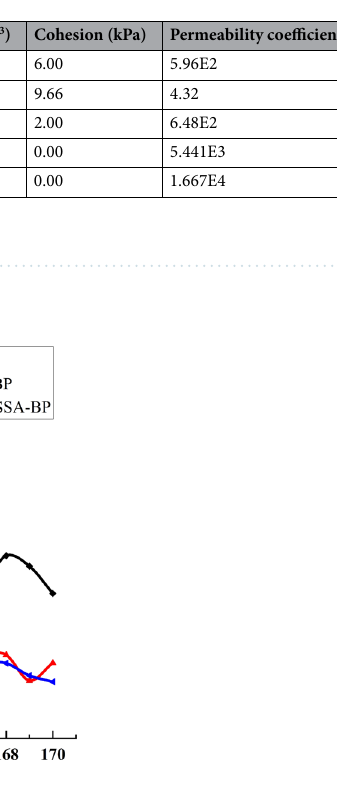
Figure 8. Comparison of BP, SSA-BP predicted value and measured value.